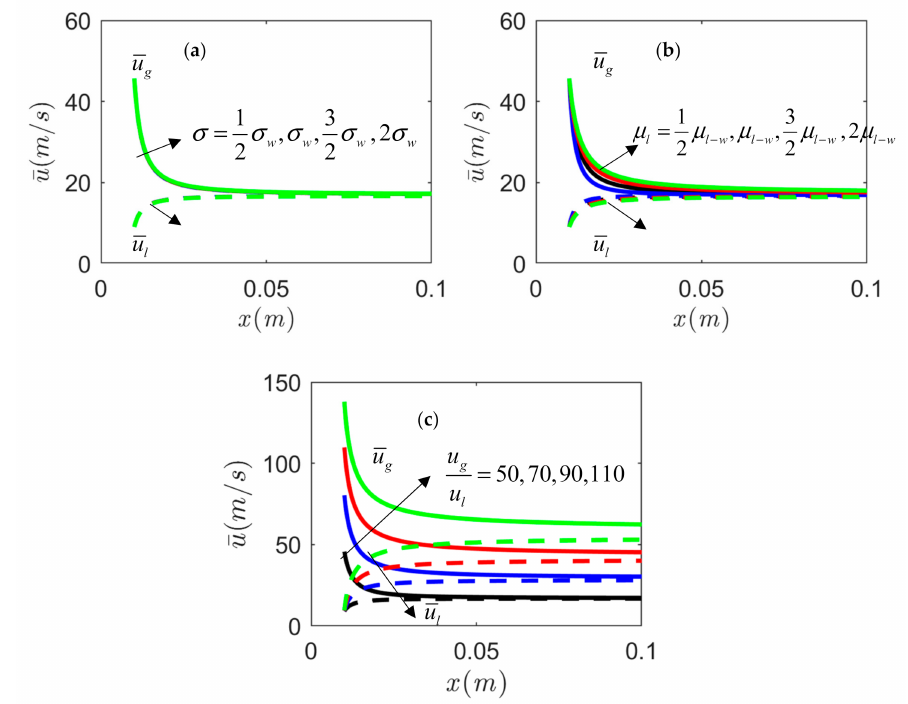
Figure 7. Impacts of formulation properties, σ and µ l , and injection gas and liquid velocity ratios, u g / u l , on ¯u g and ¯u l (shown in ( a – c ), respectively) solid lines are representing ¯u g , while dash lines are showing ¯u l . In the top panels, u g = 125 and u l = 2.5 m / s. Arrow directions show the incremental values.